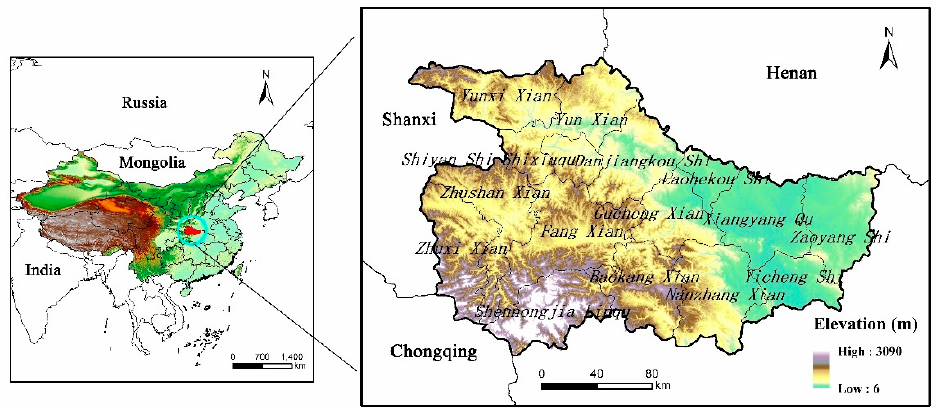
Figure 1. The location of study area.